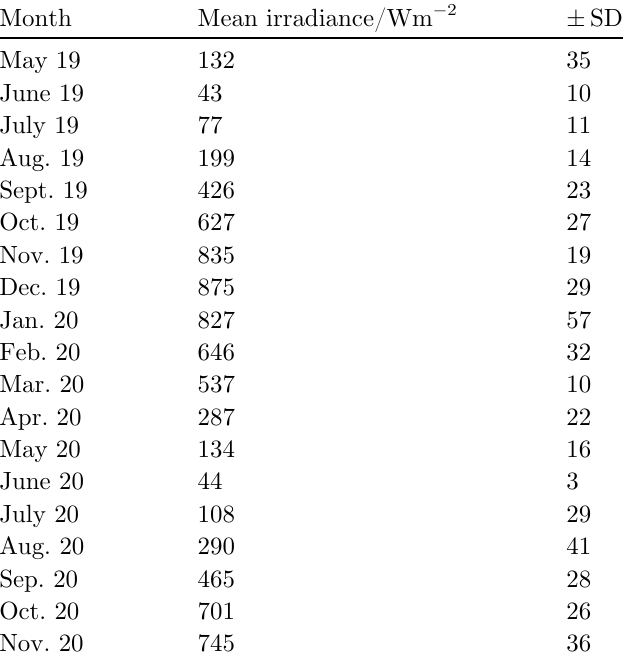
Table 1. Mean irradiance measured at a tilt angle of 45 ° , along the evaluated period. Mean and SD values were calculated from the fi ve highest values of each